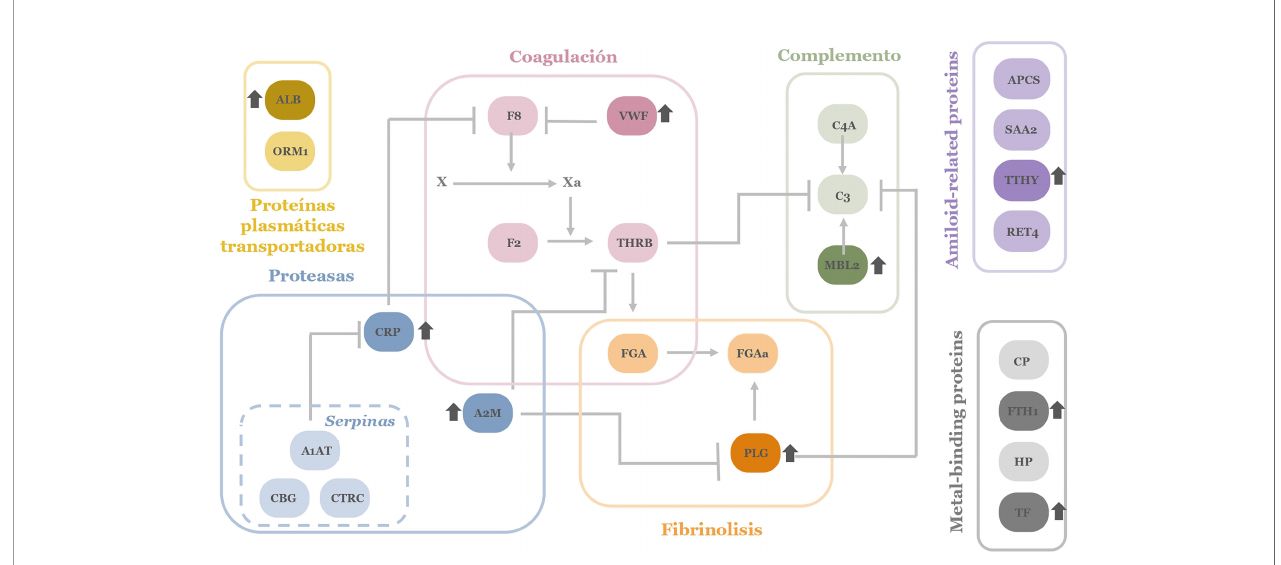
FIGURE 3 | APPs network investigated in microarray screening. The colors correspond to the different physiological processes. In darker colors those proteins that appear more elevated in patients with ARDS in the pathology of COVID-19 are depicted. ALB, Albumin; SAA, serum amyloid A; APCS, serum amyloid P;THBR, thrombin; CP, ceruloplasmin; VWF, von Willebrand factor; C3, C3 complement factor; C4A, C4 complement factor; F8, factor VIII; FTH1, ferritin; FGA, fi brinogen; HP, haptoglobin; MBL2, Mannan-binding lectin; PGA, plasminogen; CRP, C reactive protein; RET4, Retinol-binding protein; F2, prothrombin; TF, transferrin; CBG, transcortin; TTHY, transthyretin; CTRC, a -1-antiquimotripsin; A1AT, a -1-antitripsin; ORM1, a -1-glucoprote ı ́ n; A2M, y a